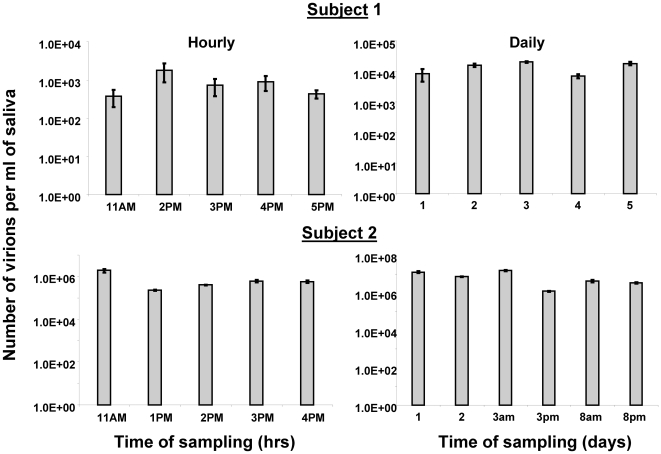
Virus shedding is stable over hours and days.The bars represent the levels of viral DNA found in saliva at the times indicated. For details see Legend to Figure 1. N.B. For the data in the lower right panel single samples were taken on day 1 and 2 but two samples taken on days 3 and 8, one in the morning(am) and one in the evening (pm).